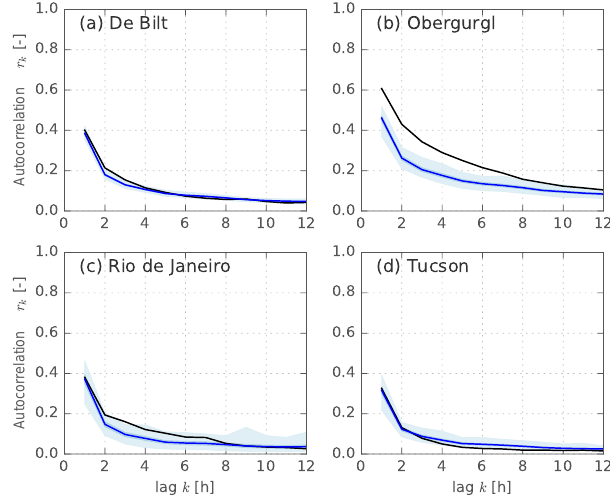
Figure 14. Autocorrelation r k as function of time lag k (in hours) plotted for modelled (blue) and observed (black) precipitation time series. For all panels the shaded areas refer to the standard devia- tion (dark blue) and range of values (light blue) computed for 100 realisations,